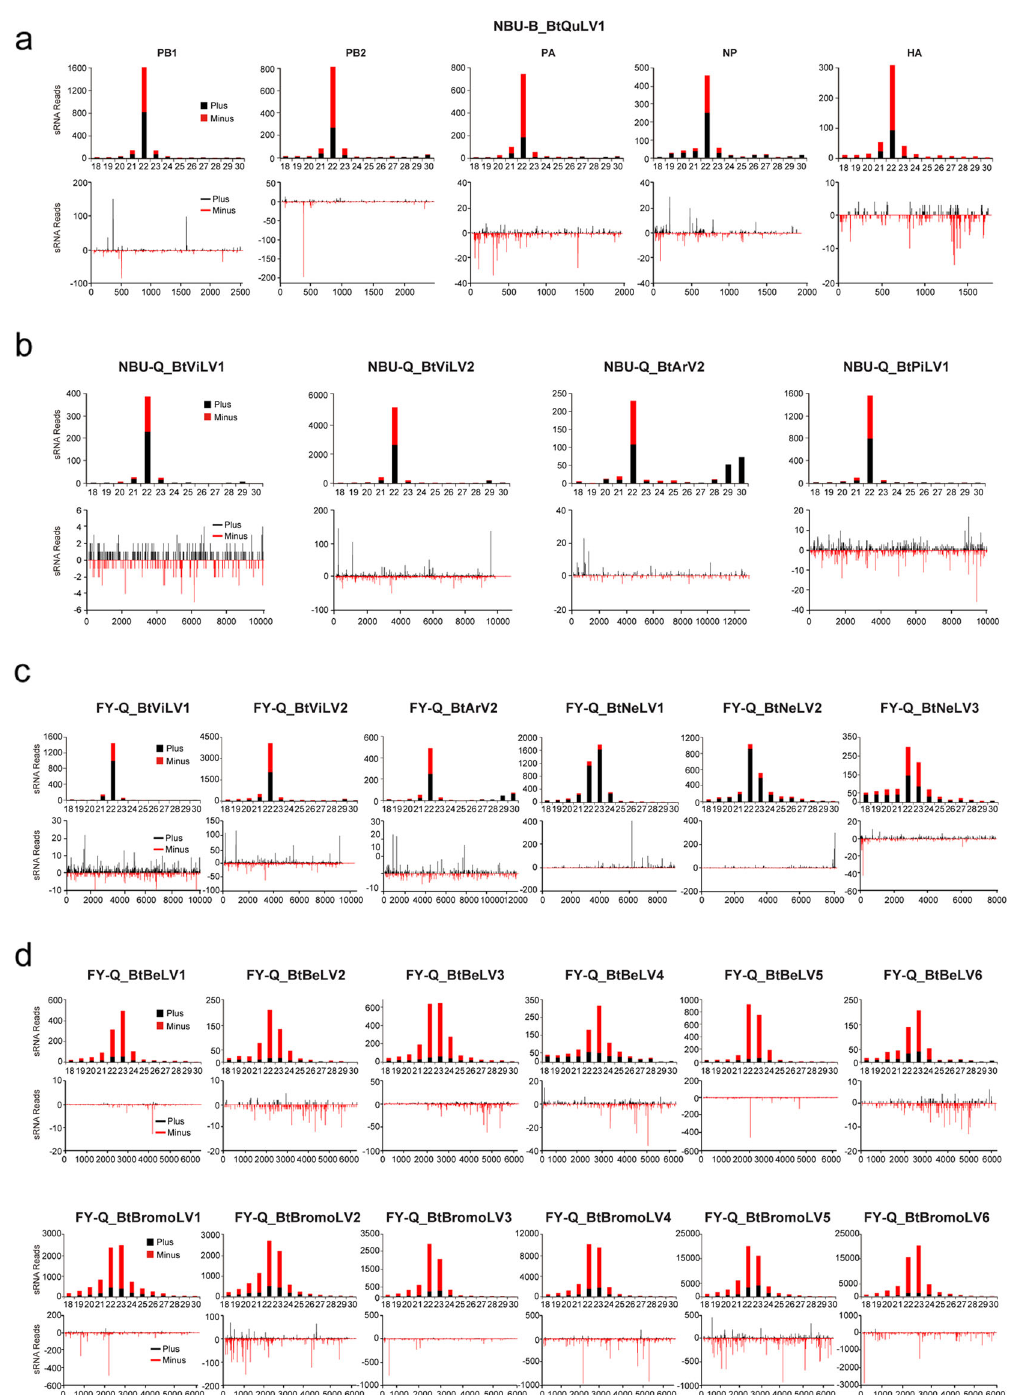
Fig. 5 Pro fi les of virus-derived small interfering RNAs (vsiRNAs). vsiRNAs derived from white fl y datasets NBU-B ( a ), NBU-Q ( b ), and FY-Q ( c , d ). The upper panel shows the size distribution of vsiRNAs, while the lower panel shows the distribution of vsiRNAs along the corresponding viral genome. Color coding shows vsiRNAs derived from the sense (black, plus) and antisense (red, minus) genomic strands. All reads in this analysis are redundant. The abbreviation of the virus names is listed in Table